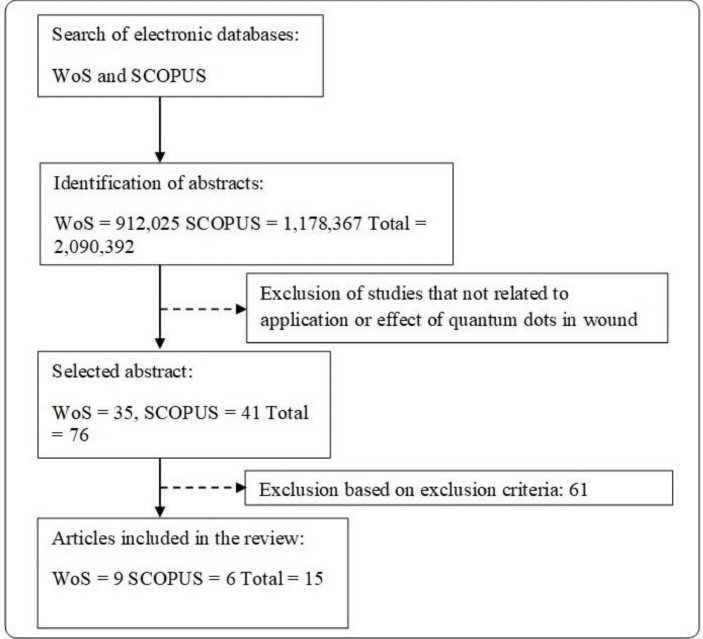
Figure 3. PRISMA flow